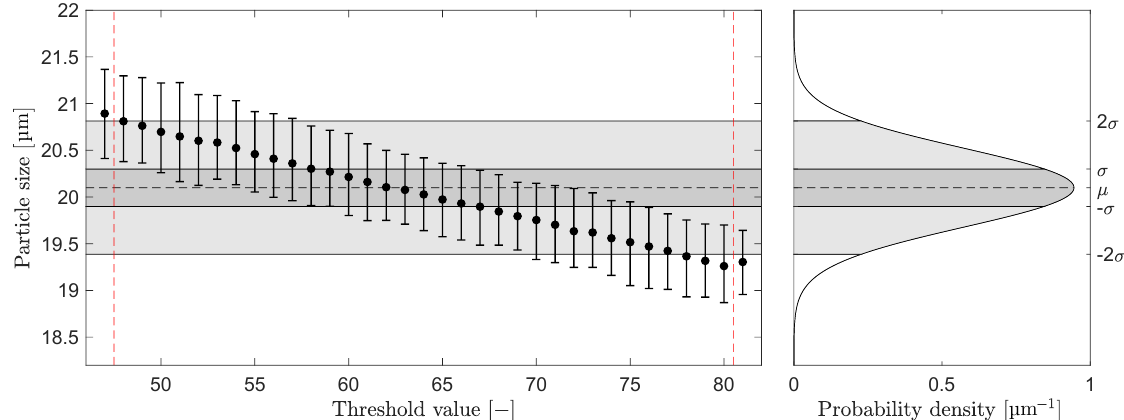
Figure 4. Selected particles, all with maximum ESV on C 2 . The error bars represent the mean, minimum, and maximum particle sizes at different THVs. The Gaussian distribution is calculated based on information from BS-Partikel: µ = 20.1 µm and σ = 0.4 µm.